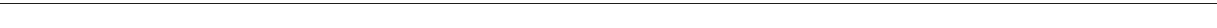
Fig. 3 The MRE sequence and its interaction with the miRNA are a major determinant of repression ef fi ciency. a Designed MREs of a given type for the selected ten miRNAs were placed in up to 57 contexts at a single copy in either of the two positions to generate a diverse set of variants. We grouped all the variants with the synthetic MREs by their binding site type, spanning different miRNAs and contexts, resulting in 2158 unique variants with measured repression. MRE types with a more extensive base pairing show higher repression. See also Supplementary Figure 2. b For each of the ten miRNAs, the perfectly complementary MRE was placed in one of the two contexts and mutated to accumulate mismatches from the MRE 5 ′ end. Each shaded square represents an unpaired base as predicted by ViennaRNA 2.0 60 . c A heatmap of the R 2 values for the fold repression as a function of the hybridization energy ( Δ G , calculated with RNAhybrid 2.1.2 68 ) for each of the ten miRNAs in each of the two contexts. All of the correlations were negative. d Scatter plot of fold repression as a function of Δ G for hsa-miR-103 in context C1, highlighted in c . e Scatter plot of fold repression as a function of Δ G for hsa-miR-223 in context C2, highlighted in c . The bar annotates the 8.4-fold difference in fold repression spanned by the different mutants. f Comparison of the effect on fold repression of mutations in three regions of the MRE for four selected miRNAs for 3 ′ complementary (top panel) and bulged (bottom panel) MRE types. The fi rst position is considered to be mutated if it is not an “ A ” . The effect of mutations in the different regions varies between miRNAs. Boxplot pairs marked with * are signi fi cantly different ( p < 0.05, Mann – Whitney U one-sided test, FDR-corrected). The fold repression level of the non-mutated MRE in each context is indicated. In each variant, two identical copies of the MREs were placed in the context in order to increase sensitivity. See